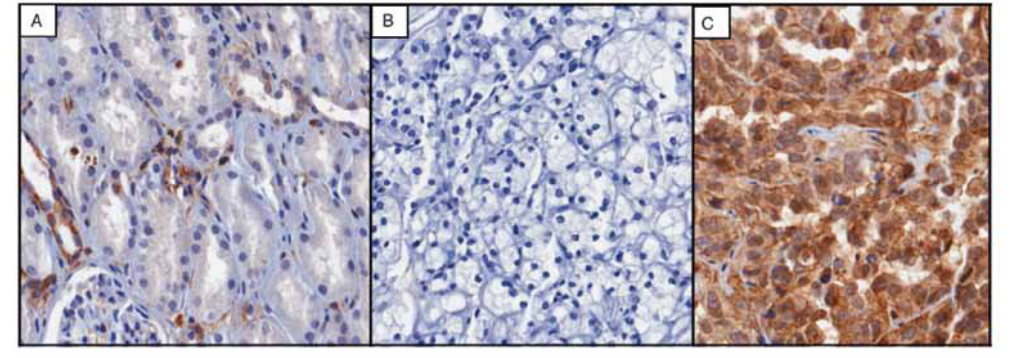
Figure 1 - Photomicrographs of immunohistochemical expression of cD44s. A. Low expression of cD44s in non-neoplastic renal cortex. B. Low expression of cD44s in Fuhrman 2 ccRcc. c. High expression of cD44s in Fuhrman 4 ccRcc. Original magnification: 400 X.